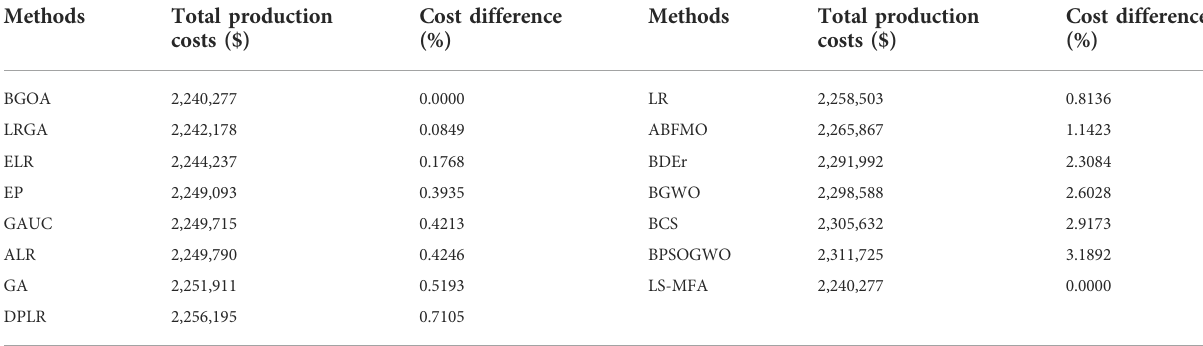
TABLE 7 Comparison of total cost with reported optimization techniques for 40-unit